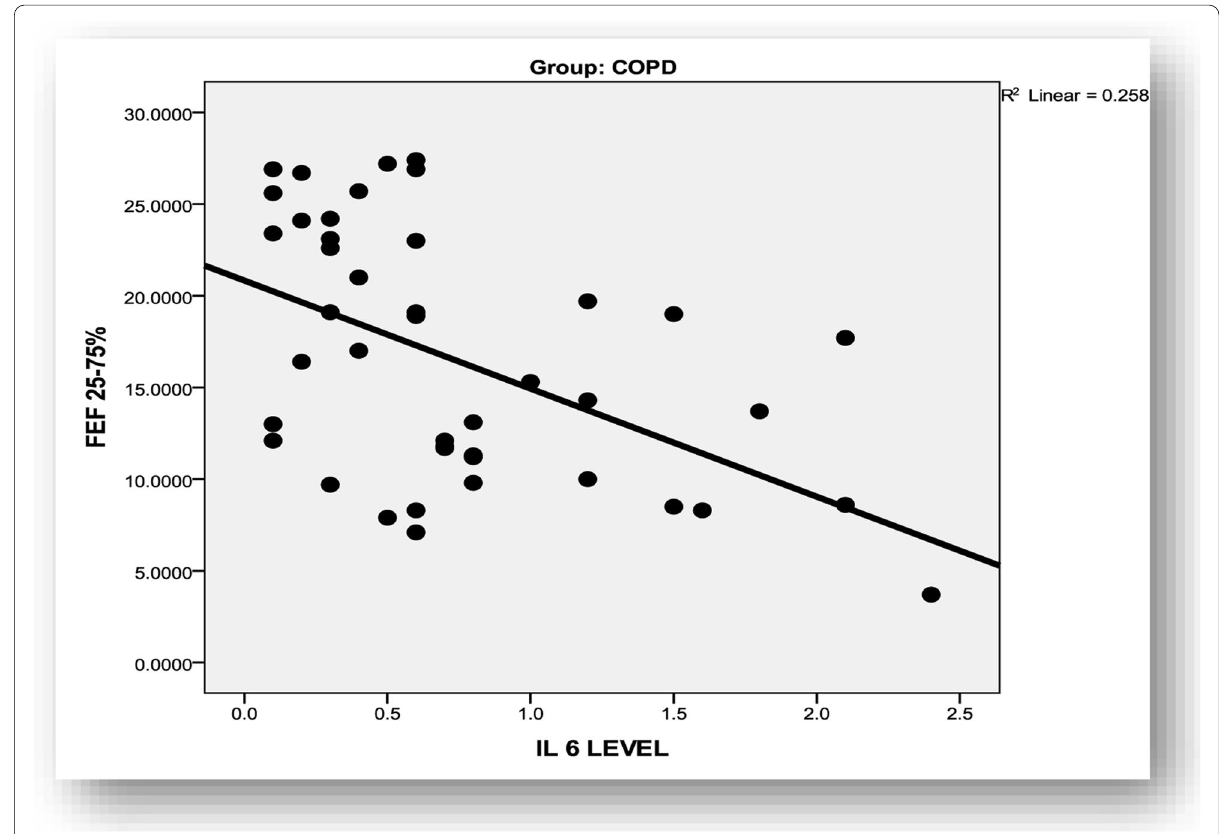
Fig. 3 Correlation between IL‑6 level with FEF 25–75% among cases of